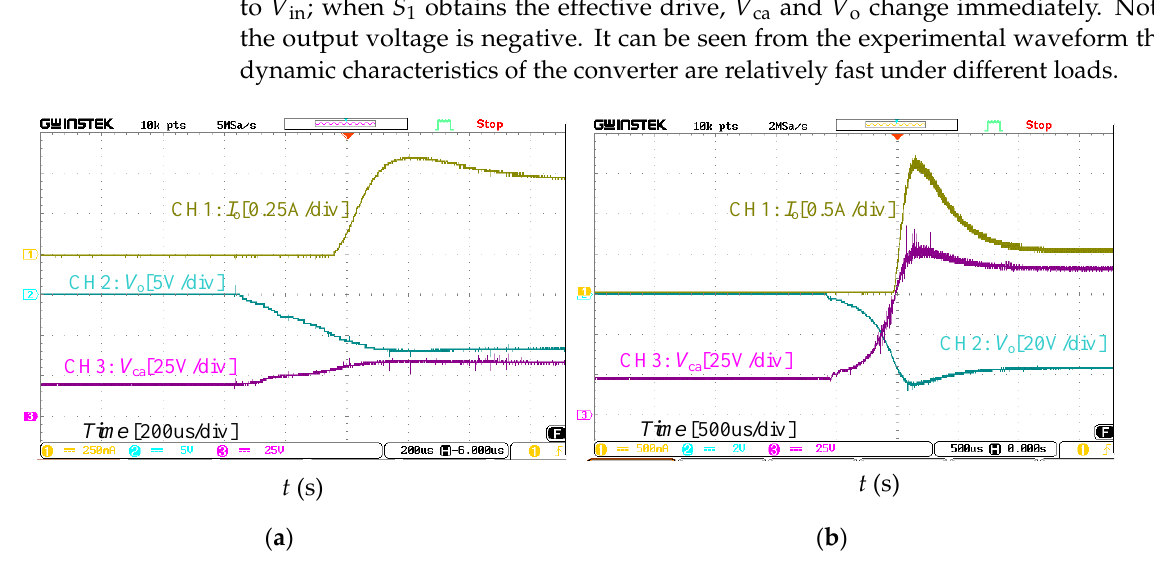
Figure 12. Startup waveforms of I o , V o , and V ca under different loads. ( a ) Output load with 2 LEDs in series; ( b ) output load with 12 LEDs in series.